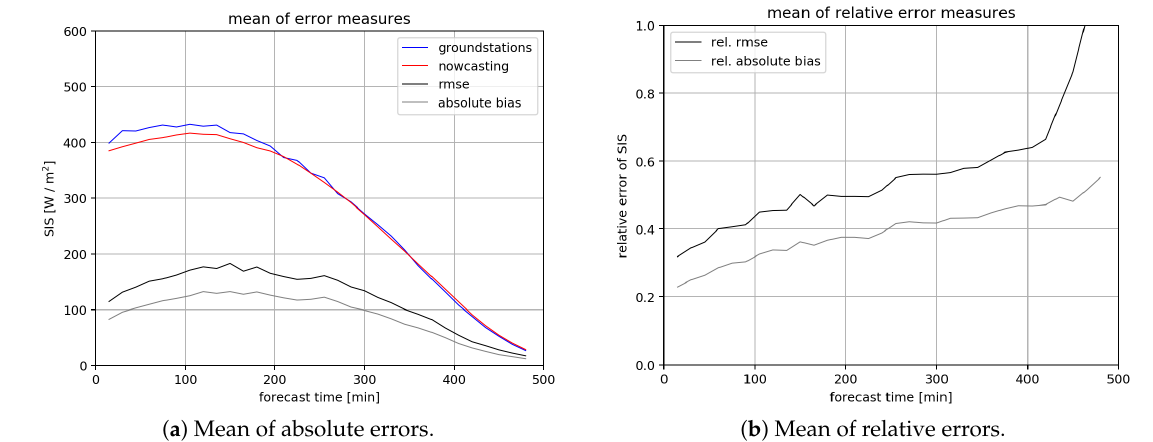
Figure 8. Plots of the mean error measures of all cases against forecast time for absolute ( a ) and relative errors ( b ). The validation of the solar surface irradiance was performed with ground stations by BSRN and